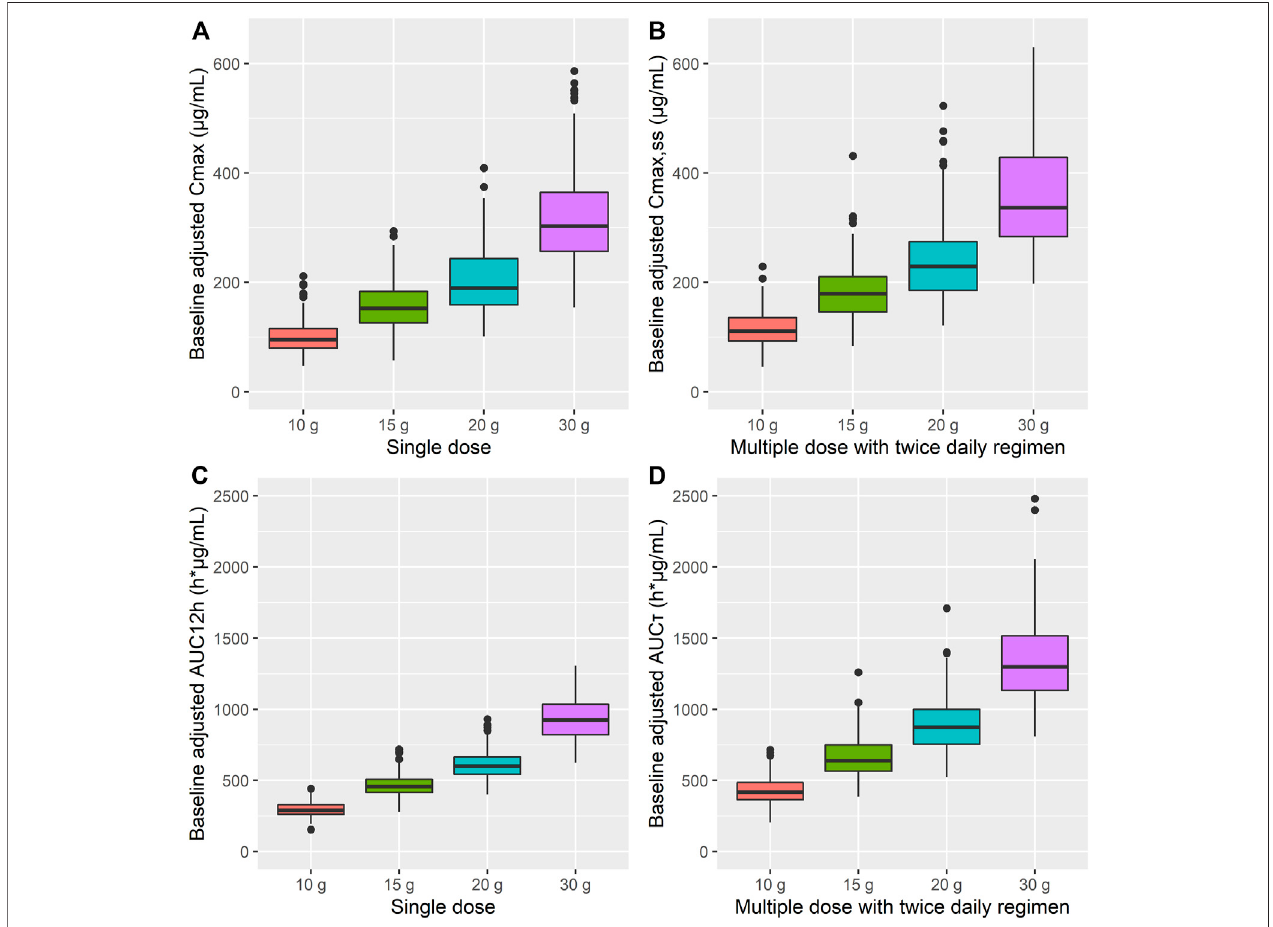
FIGURE 4 | Simulation results for baseline-adjusted (A) C max , (B) C max,ss , (C) AUC 12h , and (D) AUC τ after single and 7-days twice-daily multiple administration of 10, 15, 20, and 30 g doses of AST-001 in healthy subjects. The dots are outliers that exceed the 25 th and 75 th quartile range. C max , maximum plasma concentration; C max,ss , C max at steady state; AUC 12h , area under the curve (AUC) from 0 to 12 h; AUC τ , AUC over the dosing interval.